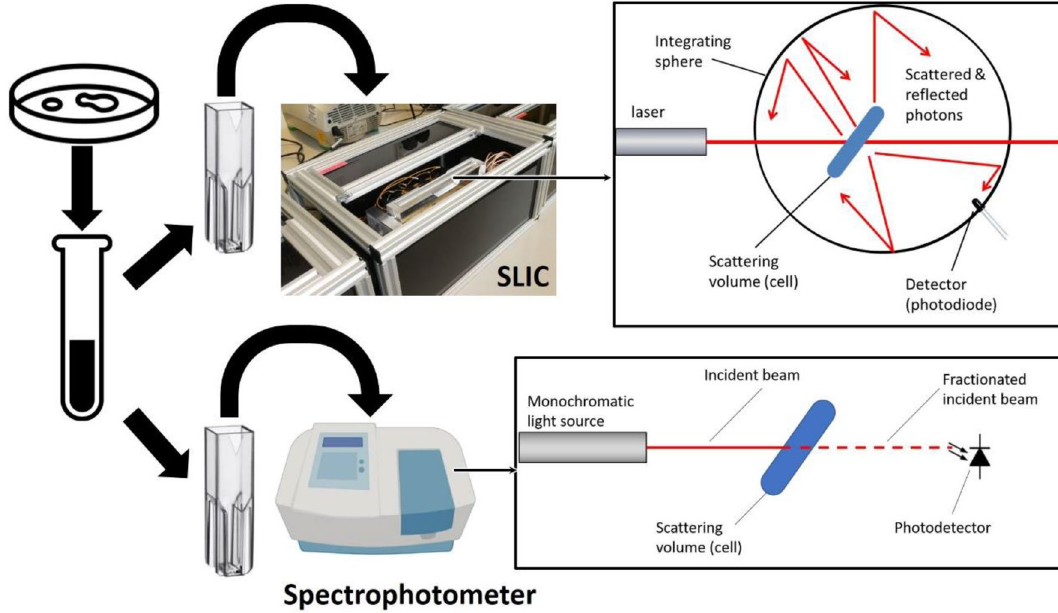
Figure 1. Brief schematic of the laboratory workflow common to both the use of a spectrophotometer and to the most basic use of SLIC, incorporating a diagrammatic representation of the differing light paths in both technologies. Data derived from a comparison experiment akin to the one shown in this figure can be found in Fig.